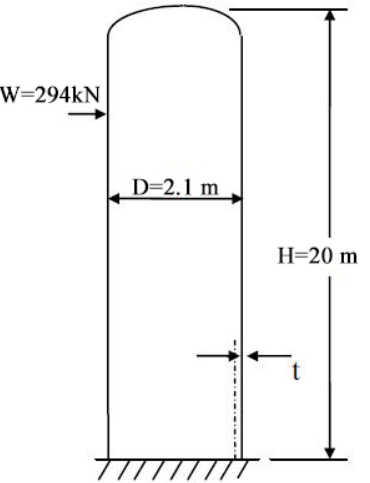
Figure 28. Uniform cylindrical column (After Reference [5], modified).